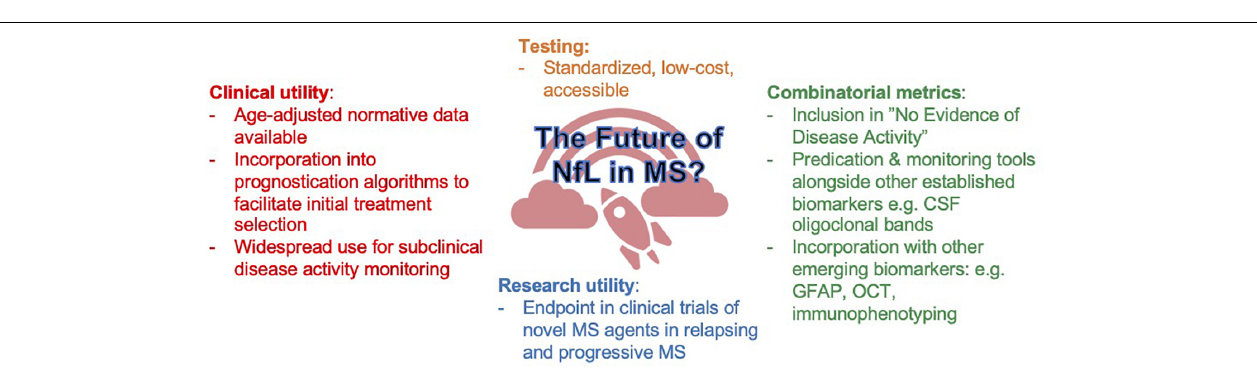
FIGURE 3 | Aspirational predictions of sNfL in the next 5–10